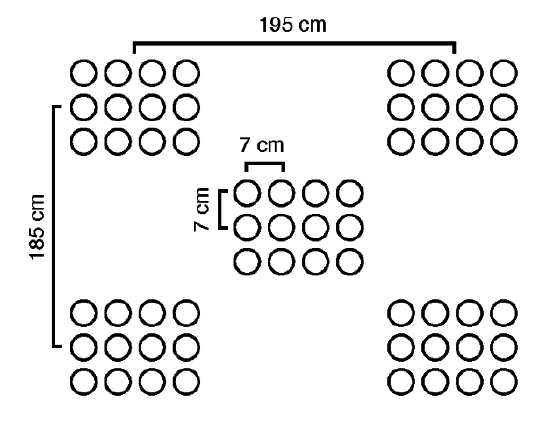
Fig. 1. Schematic of the artificial flower array used in foraging experiments. Each circle represents an artificial flower and each group of 12 flowers makes up a